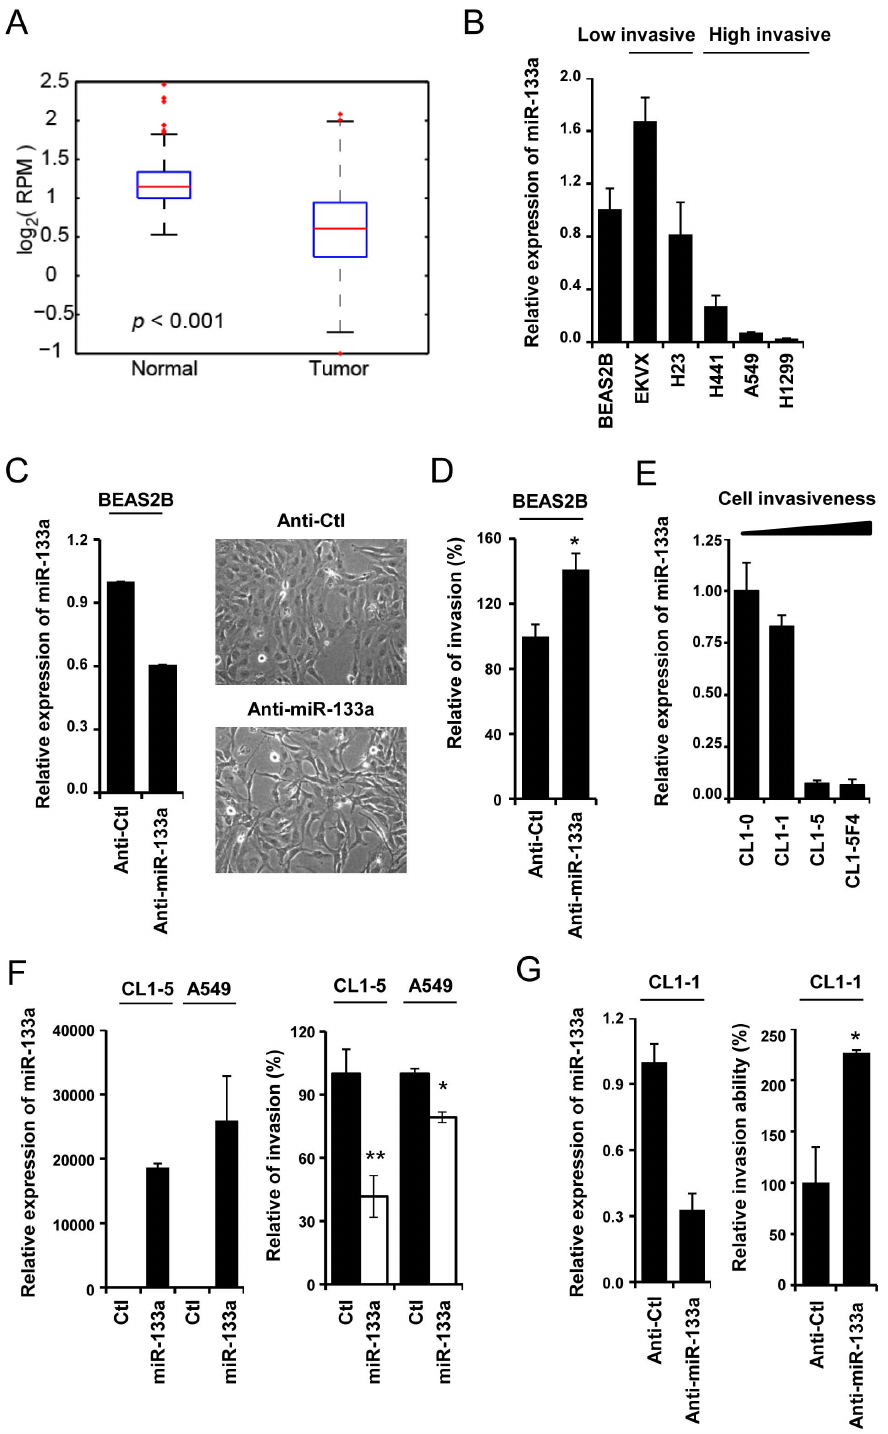
Figure 1. The miR-133a tumor suppressor modulates cell invasive capacity in lung cancer. (A) The expression levels of miR-133a in 434 tumor tissues and 46 normal tissues from the TCGA lung adenocarcinoma database were examined. (B) The expression level of endogenous miR-133a in BEAS-2B, EKVX, H23, H441, A549 and H1299 cell lines. MiR-133a expression level (C, left panel), as measured by real time RT-PCR, and cell morphology (C, right panel) in BEAS-2B cells were examined 72 hours after transfection of the anti-miR-133a inhibitor. (D)The number of invasive cells was counted 24 hours after seeding cells that post-treated anti-miR-133a inhibitor (100 nM) for 48 hours in a transwell containing matrigel. (E) The endogenous level of miR-133a in CL1-0, CL1-1, CL1-5 and CL1-5F4 cells. (F) Measurement of the invasion in CL1-5 and A549 cells transiently infected with the AS2-Neo (Ctl) or AS2-Neo-miR-133a-expressing viruses (right panel). The expression level of miR-133a was normalized to that of RNU48, which was used as an internal control (left panel) (G) 48 hours after transient transfection of the anti-miR-133a inhibitor, the invasive capacity of CL1-1 cells was determined (right panel). The expression level of miR-133a was normalized to that of RNU48, which was used as an internal control (left panel). doi:10.1371/journal.pone.0096765.g001 PLOS ONE |